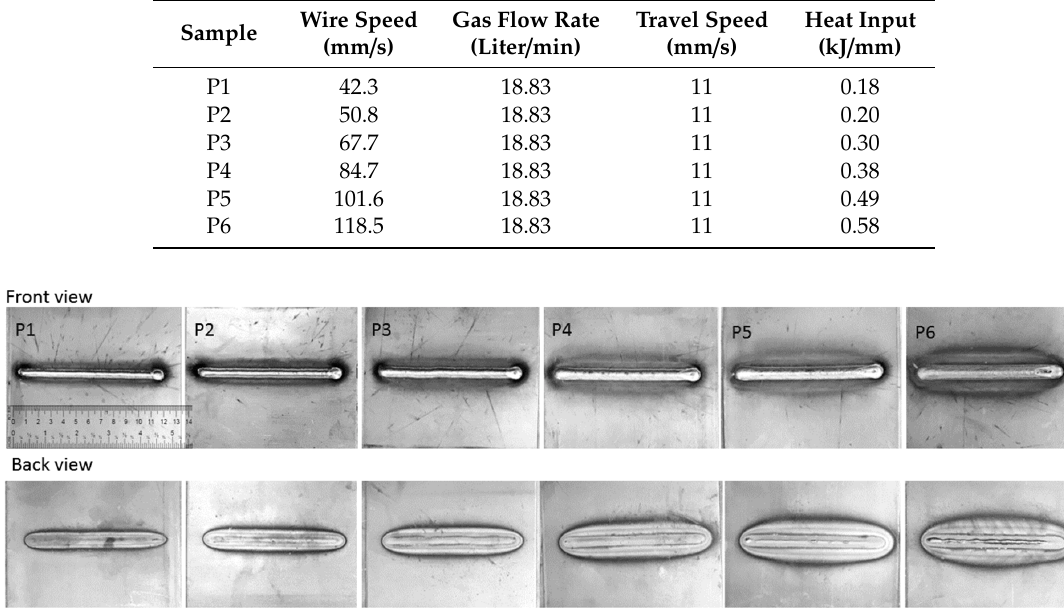
Figure 2. The front and back views of six samples.